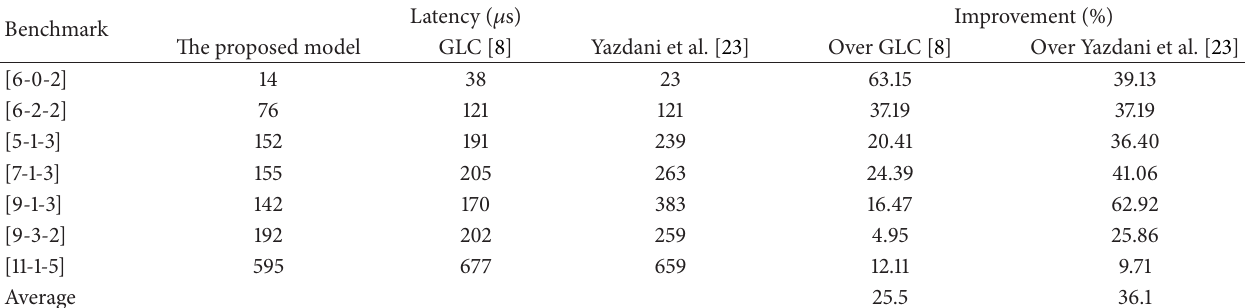
Table 4: The latency of the benchmark circuits achieved by the proposed approach compared with [8, 23].